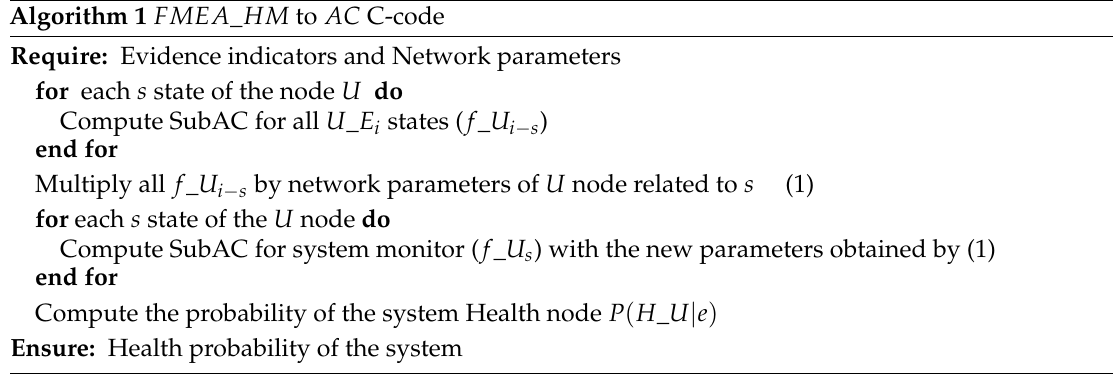
Algorithm 1 FMEA _ HM to AC